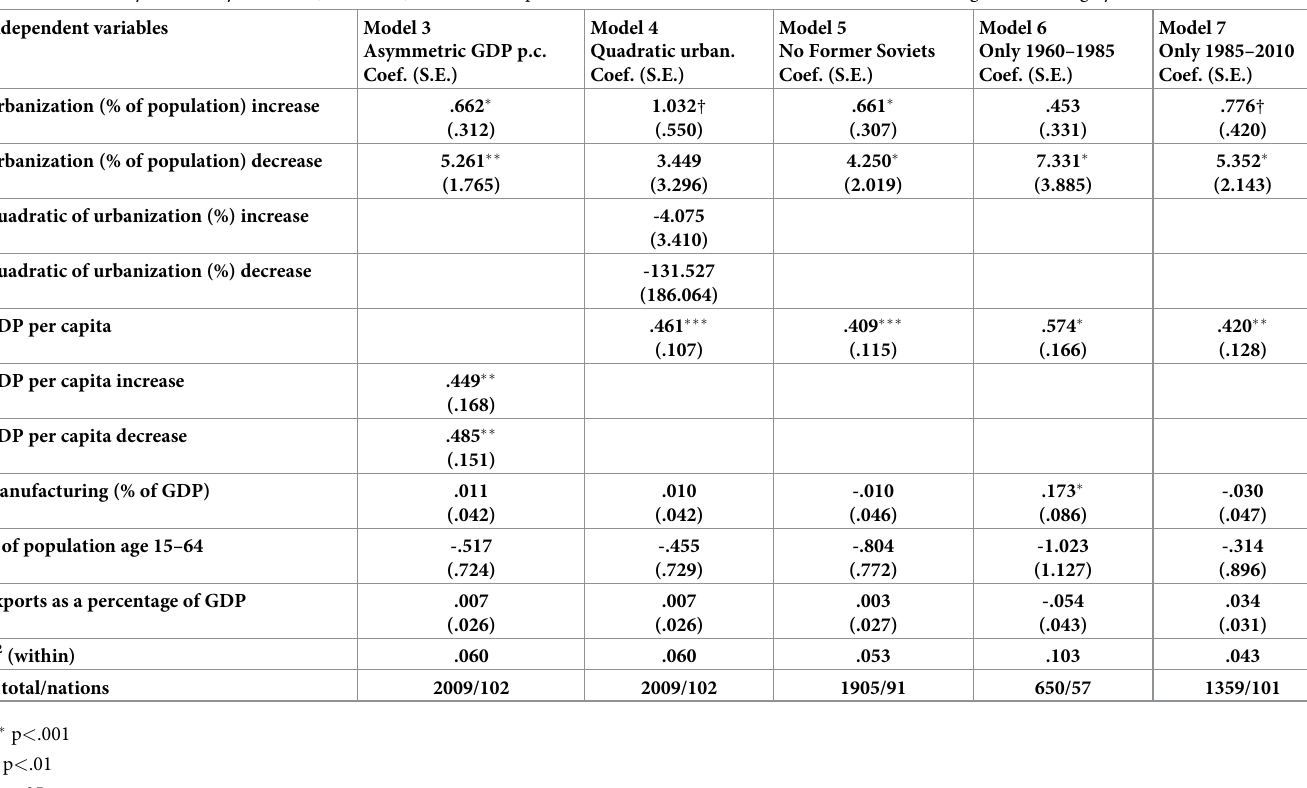
Table 2. Auxiliary models. Generalized least-squares panel regression models of the influence on CO 2 per capita in LDCs. All variables are in natural logarithmic form. All models include year dummy variables (not shown) to control for period effects. The standard errors are robust, accounting for clustering by